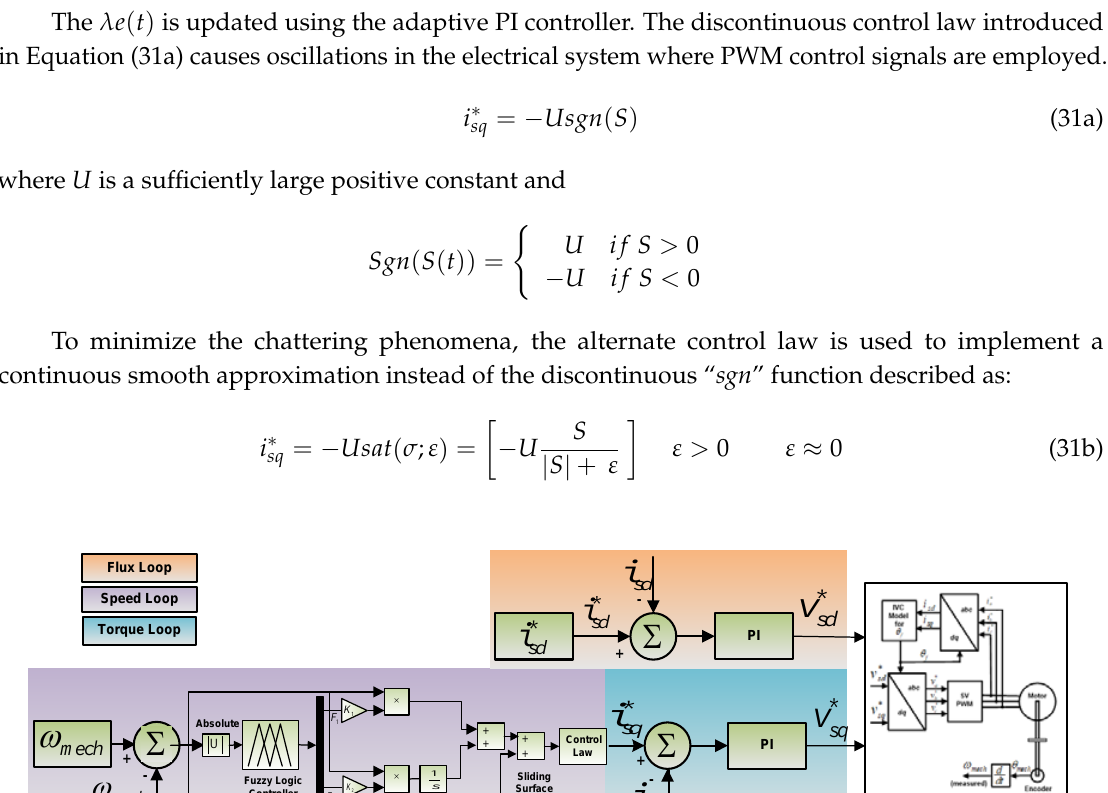
Figure 11. Speed control of indirect field oriented control IM using a PI controller. 0